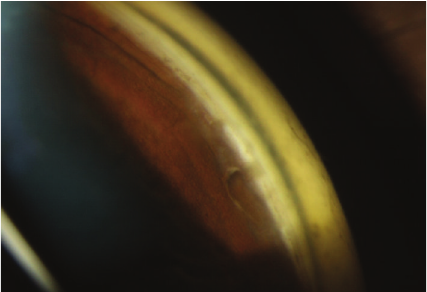
Figure 2: Postsurgery gonioscopic view of ab interno trabeculo-